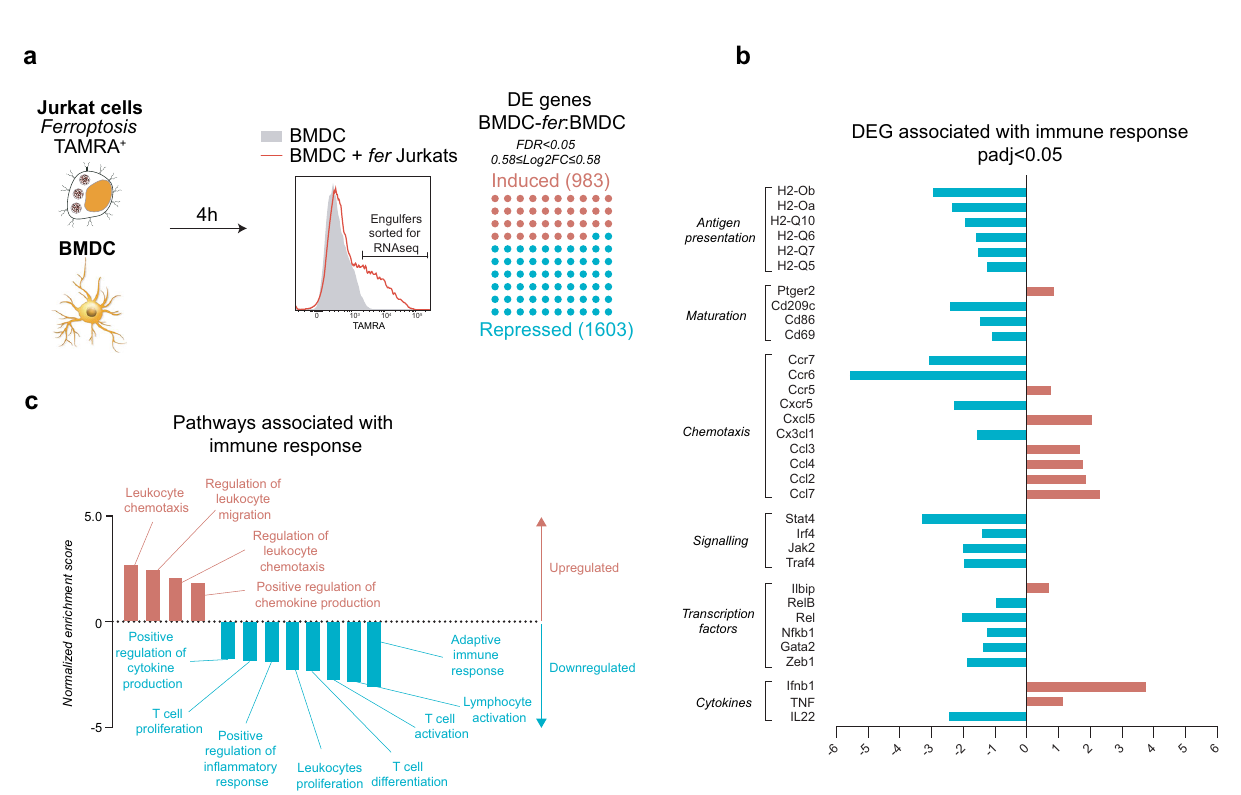
Fig. 4 Engulfment of ferroptotic cells by DC suppresses expression of genes associated with adaptive immune response. a Fluorescently labeled ferroptotic Jurkat cells were co-cultured with BMDC for 4 h after which BMDC carrying ferroptotic cargo were sorted and subjected to murine total RNA sequencing ( n = 4 independently collected samples). Uptake of ferroptotic Jurkat cells led to transcriptional changes in 2586 genes. b Expression of selected genes involved in adaptive immune response. c GSEA pathway analysis of BMDC carrying ferroptotic cargo revealing transcriptional changes in pathways involved in inducing adaptive immune